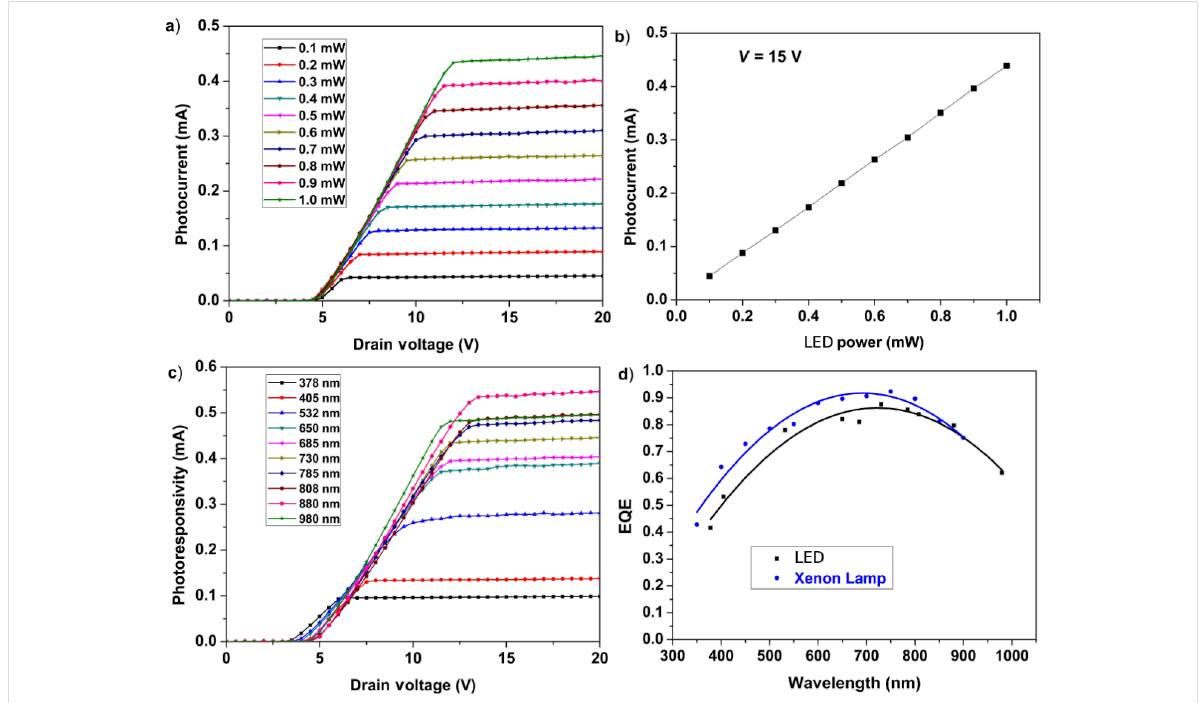
Figure 5: (a) Photocurrent induced by a 730 nm continuous wave, low power light source at various illumination intensities. (b) Photocurrent linearity at a drain voltage 15 V and wavelength of 730 nm. (c) Photocurrent induced at different wavelengths. (d) Comparison between the device external quantum efficiency (EQE) measured with an LD and a xenon lamp, filtered at different wavelengths.